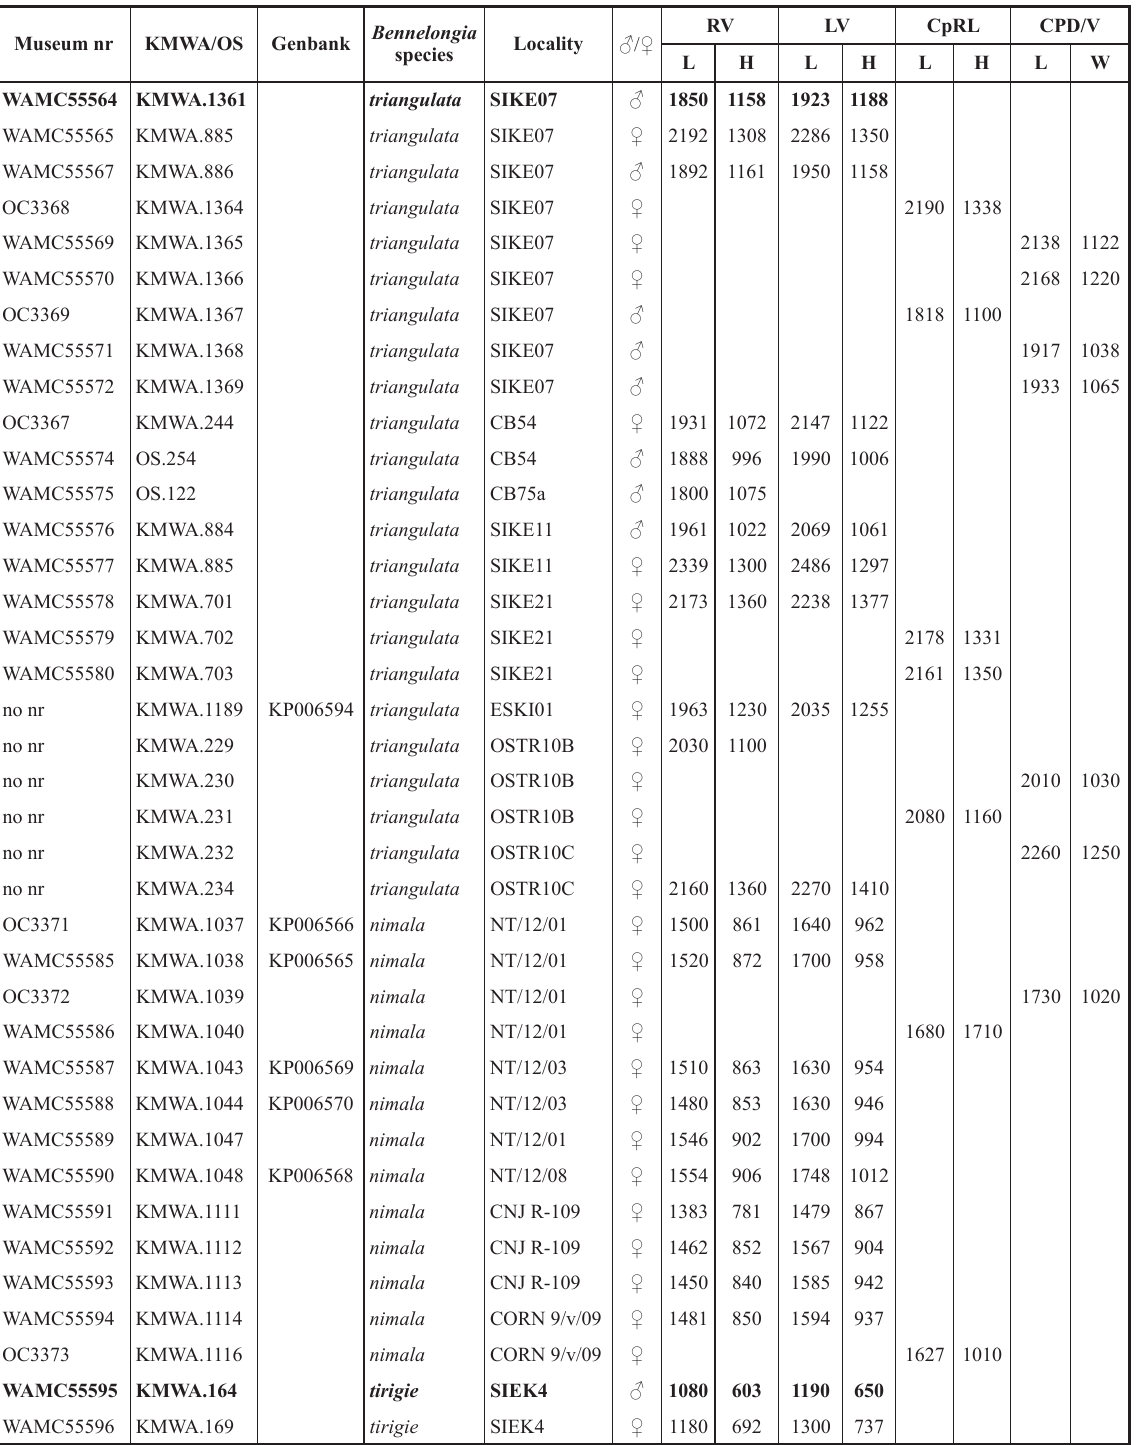
Table 1. Individual measurements of specimens used for the present descriptions. all measurements were done using SEM (see Material and methods). If a molecular sequence was available for the same specimen, the GenBank registration number is also given. However, some specimens were used as whole animals for Dna sequencing, and thus no measurements are available. the present table therefore does not list all 54 specimens for which sequences are available. specimens in bold are holotypes. abbreviations: see Material and